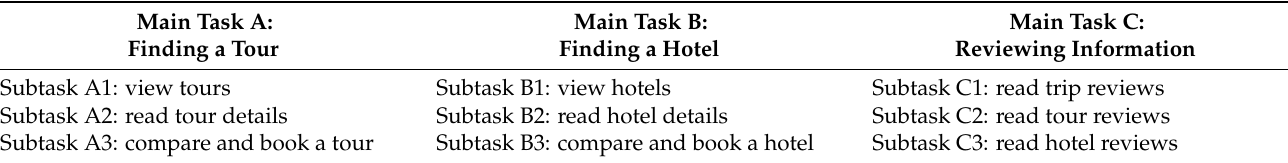
Table 3. Each main task was divided into three subtasks.